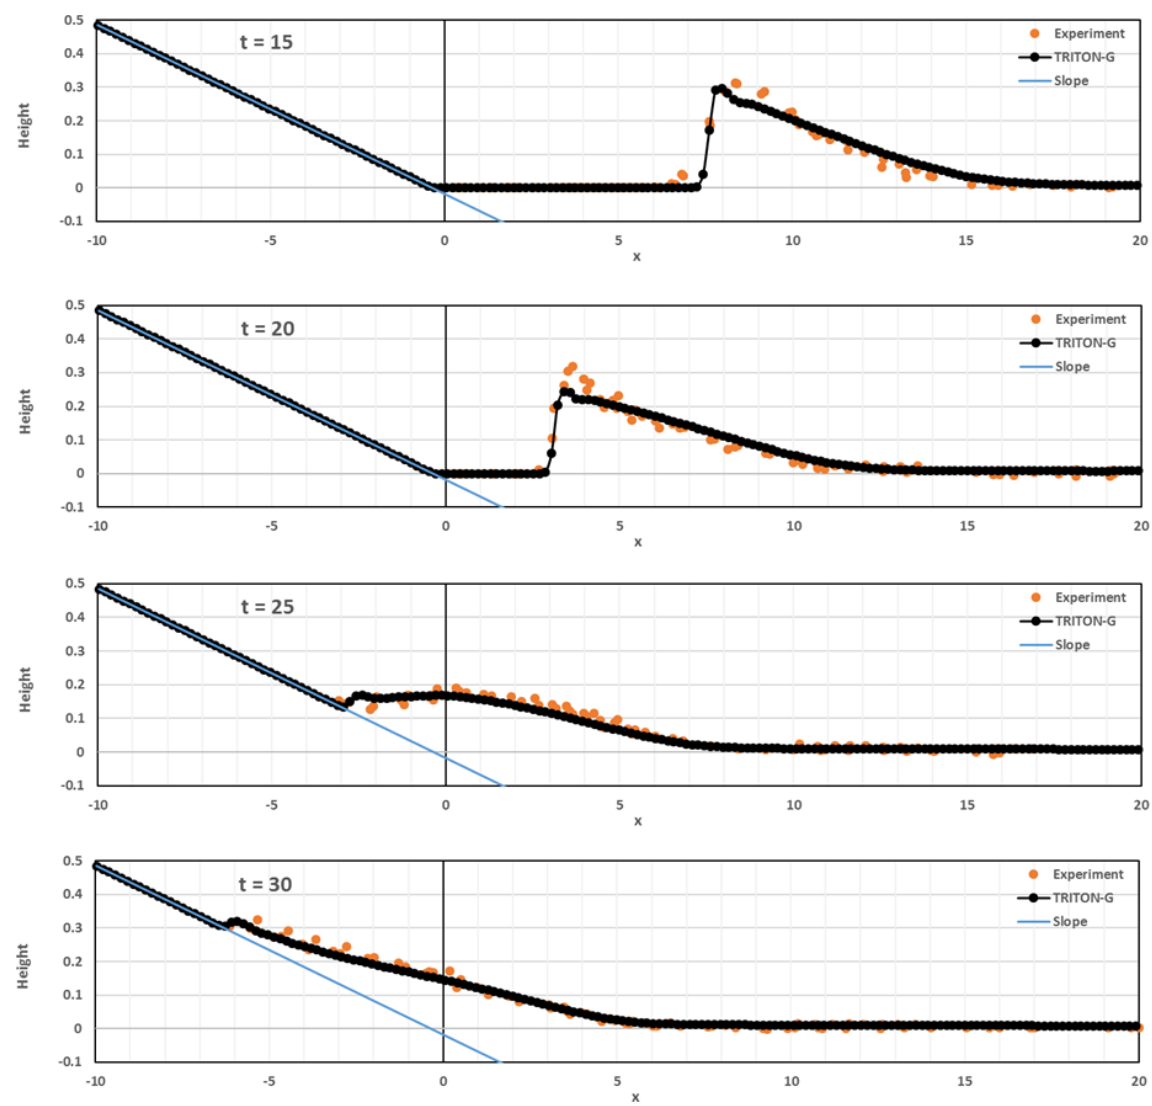
Figure A3. Comparison of numerically calculated free surface profile at different dimensionless times for the breaking case H/d = 0 . 30.